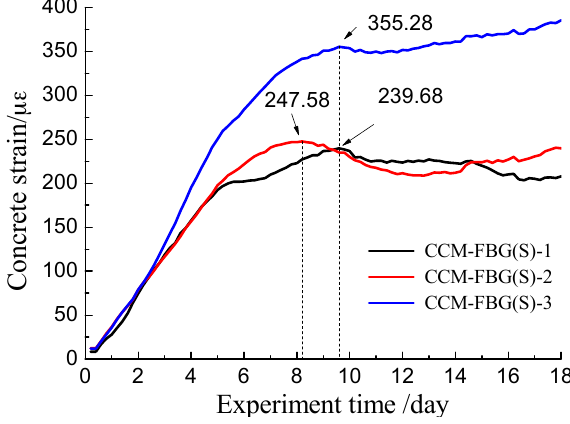
Figure 10. Stage of electrically accelerated corrosion cracking. Figure 9. Stage of electrically accelerated corrosion